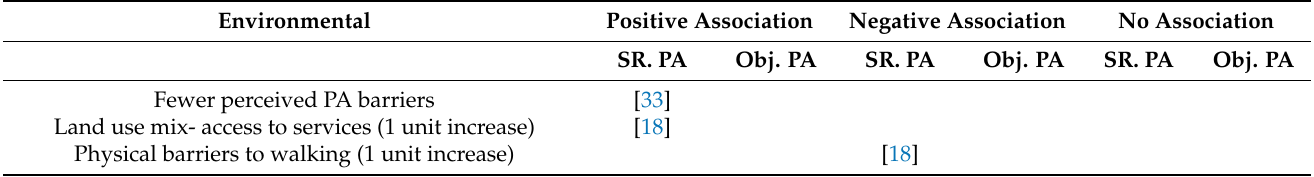
Table 8. Environmental factors associated with MVPA.